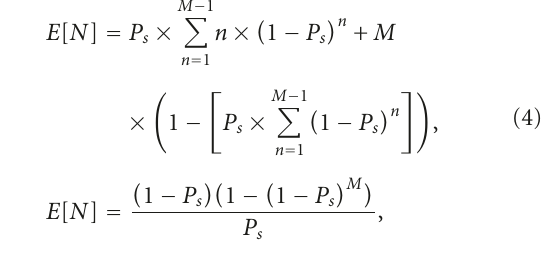
Figure 1: Packet delay against P e (logarthmic horizontal scale) for varying values of M (max number of